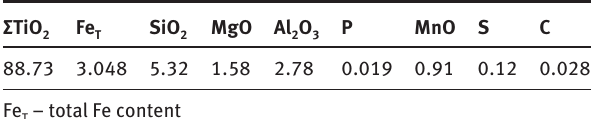
Table 1: Main chemical composition of high titanium slag